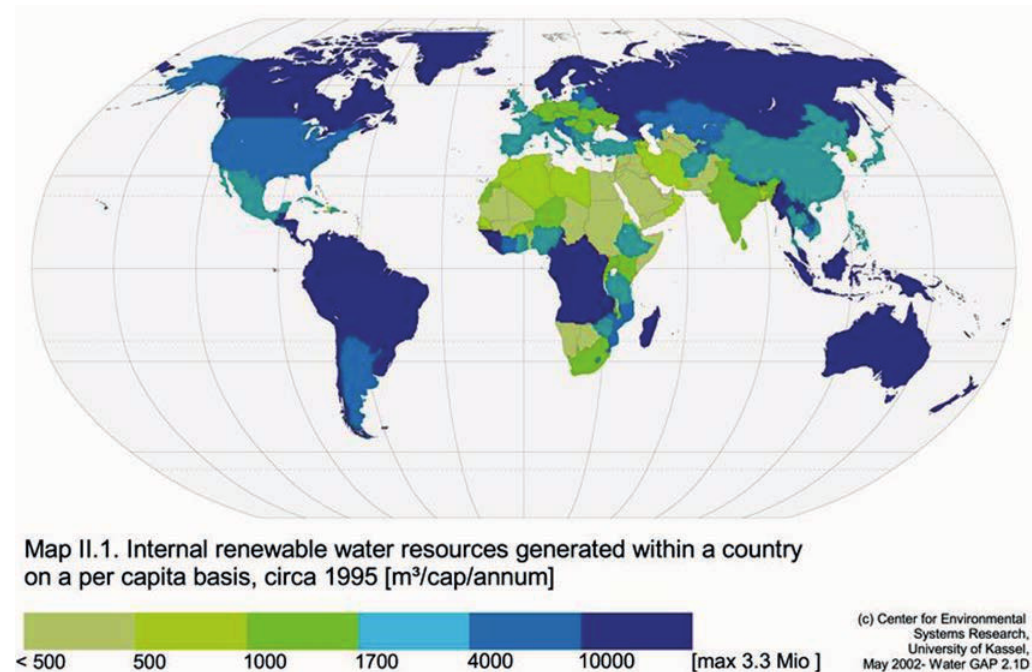
Fig. 1 Worldwide internal renewable water